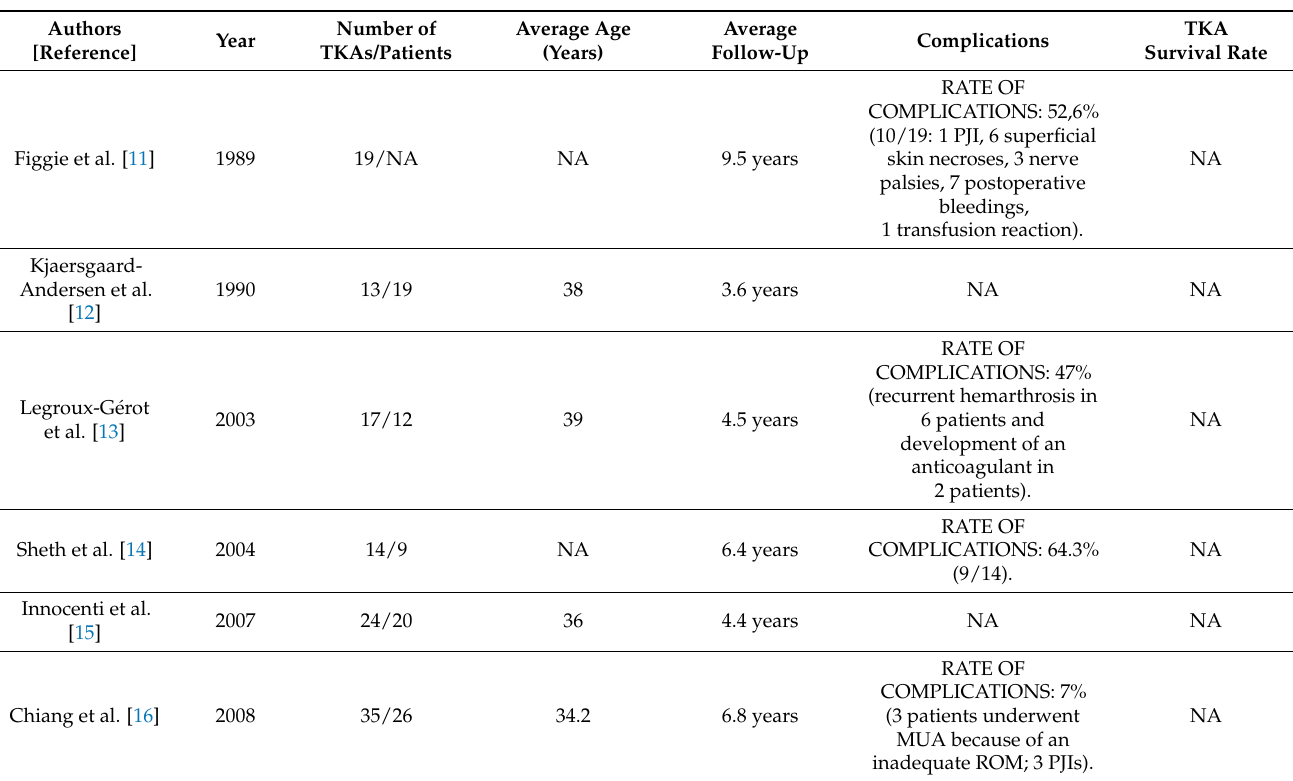
Table 1. Series of total knee arthroplasty (TKA) in people with hemophilia (PWH) published in the